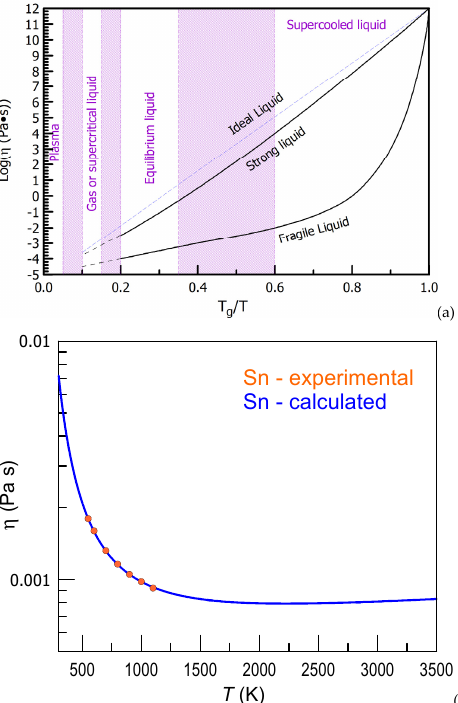
Figure 5. ( a ) A schematic plot of the viscosity as a function of temperature for strong and fragile liquids together with the corresponding phase regions. Filled areas represent the temperature regions of liquidus, boiling and plasma formation temperatures depending on the alloy composition. Reproduced from [13] with permission of Materials Research Forum LLC. ( b ) Temperature dependence of viscosity of Sn calculated by Formula (4) according to Ref. [75] and experimental viscosity values from Ref. [91]. Also, boiling of liquid must be avoided by applying an overcritical external pressure [89]. The high-temperature part of the viscosity plot cannot exist below the critical point on pressure—temperature phase diagram. Above this point a liquid/gaseous phase can reach high temperatures without undergoing boiling but it inevitably transforms to plasma at extremely high temperatures. Rise of viscosity of supercritical fluids with temperature was predicted [93] and observed before [94]. Here one should also mention